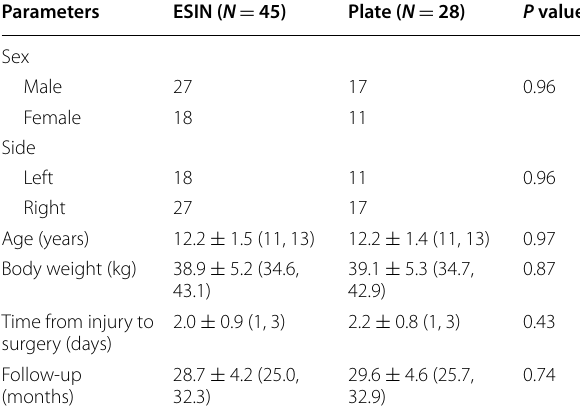
Values of continuous variables are described as mean ESIN elastic stable intramedullary nail